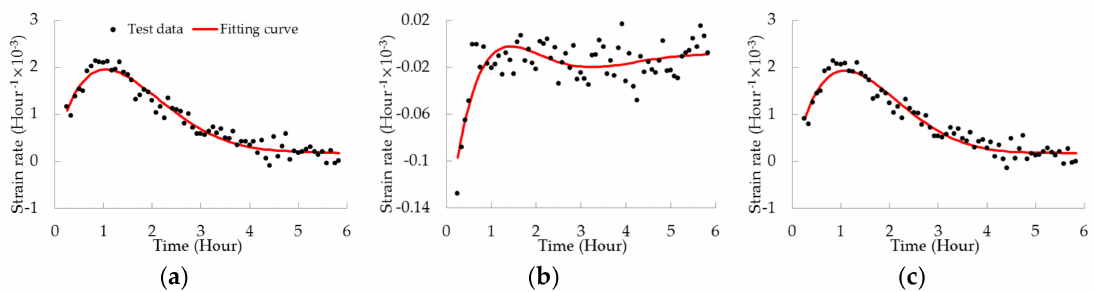
Figure 5. Strain rates versus time graphs for the coal sample compressed at 8.03 MPa: ( a ) axial strain rate (r a ); ( b ) radial strain rate (r r ); ( c ) volumetric strain rate (r v ).